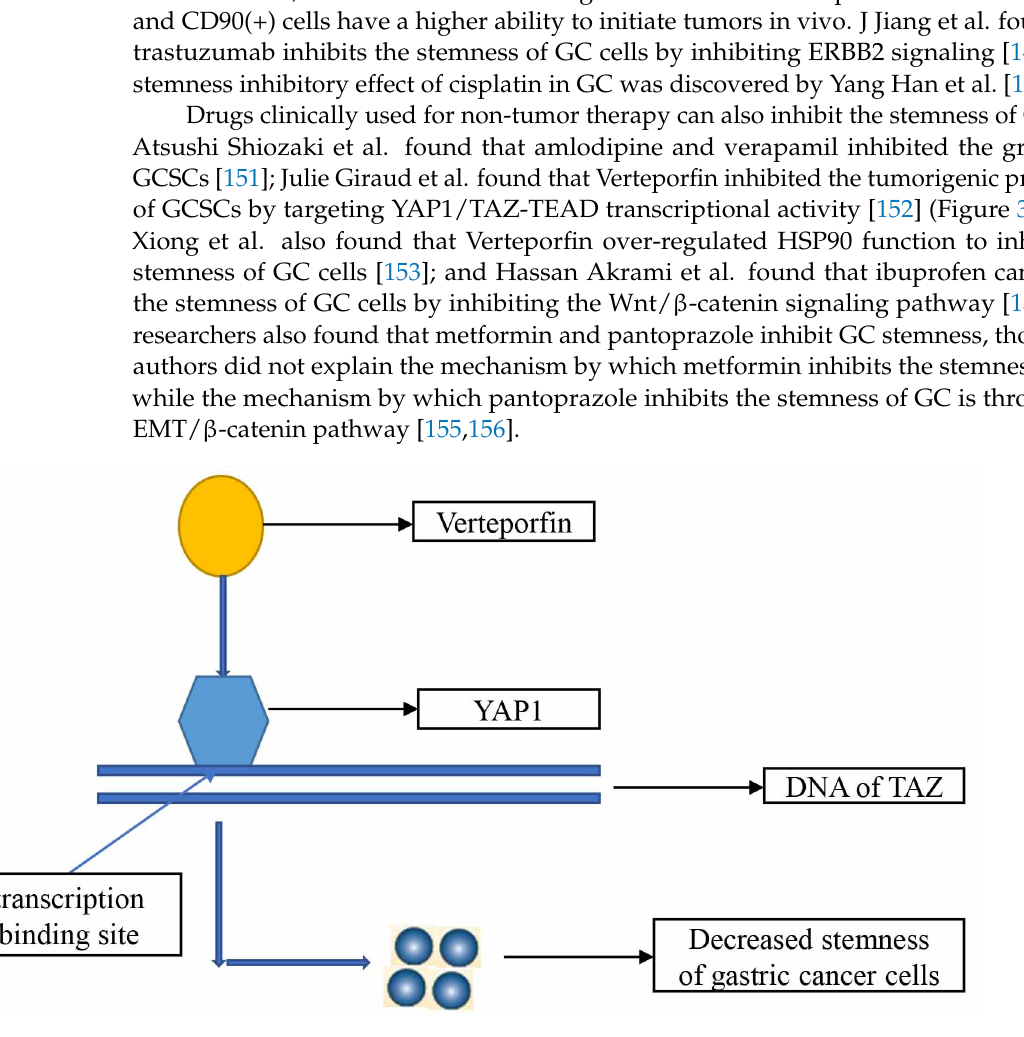
Figure 3. Verteporfin inhibits tumorigenic properties of GCSCs by targeting YAP1/TAZ transcrip- tional activity.